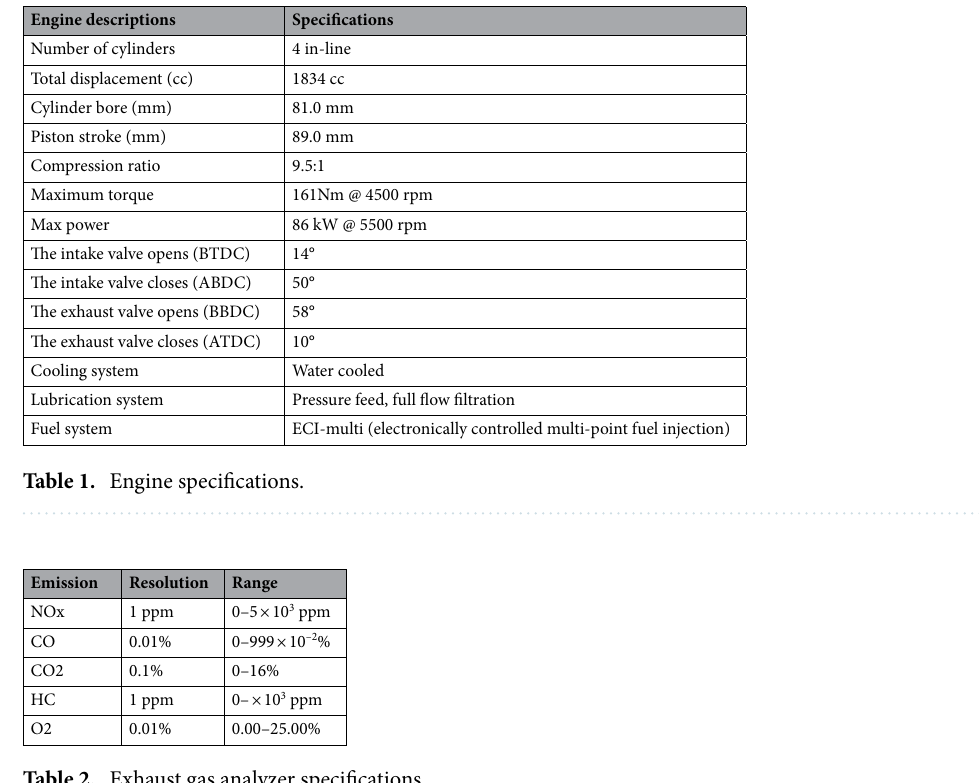
Table 2. Exhaust gas analyzer specifications.